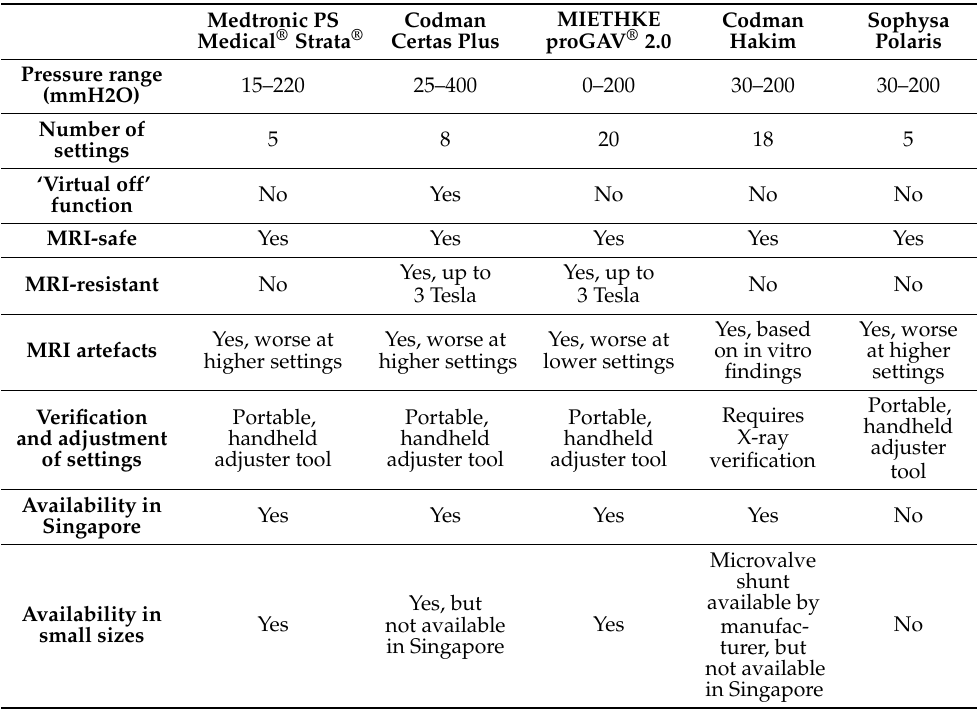
Table 1. Opening pressures of selected fixed pressure shunts and programmable shunts [20–25]. (Of note, the standard setting for the Sophysa Polaris ® allows for opening pressures to be adjusted between 30 mmH2O and 200 mmH2O; additional options, however, are available: 10–140 mmH2O, 50–300 mmH2O, or 80–400